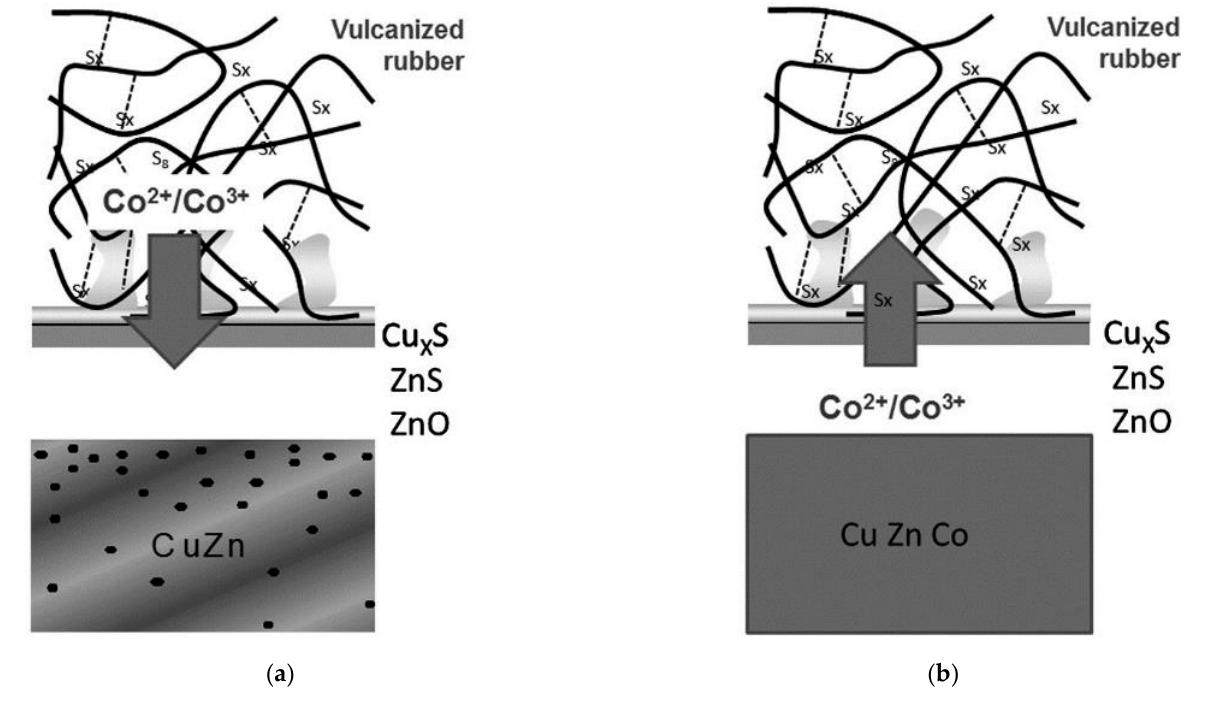
Figure 25. Comparison of the adhesion mechanism: ( a ) brass-coated steel cord in a Co-containing compound and ( b ) Cu-Zn–Co TAWI ® in a Co-free compound. Reprinted with permission from ref. [58].